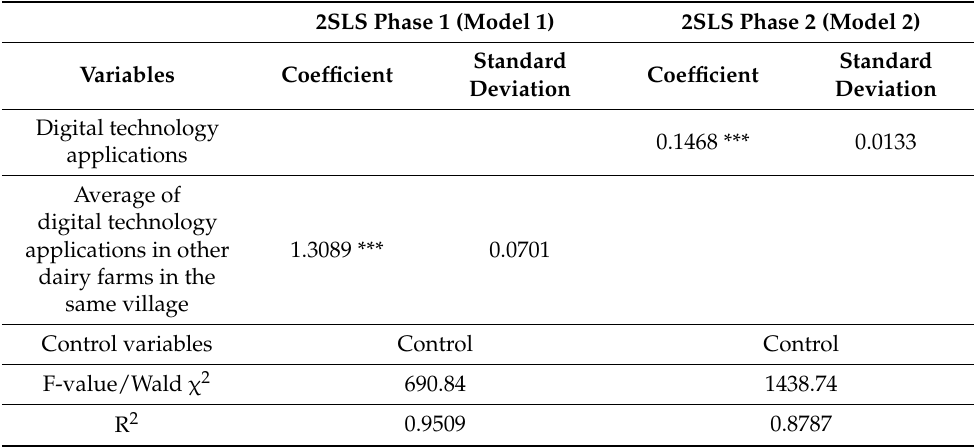
Table 11. Estimation results of the instrumental variable